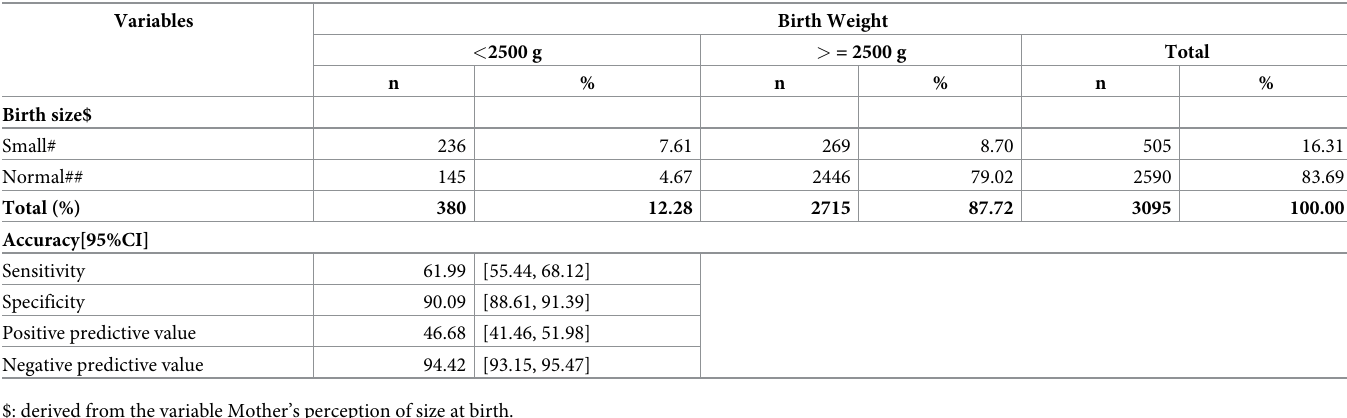
Table 2. Accuracy of mother’s perceived baby birth size to predict LBW, NDHS 2016 (N = 3095). Variables